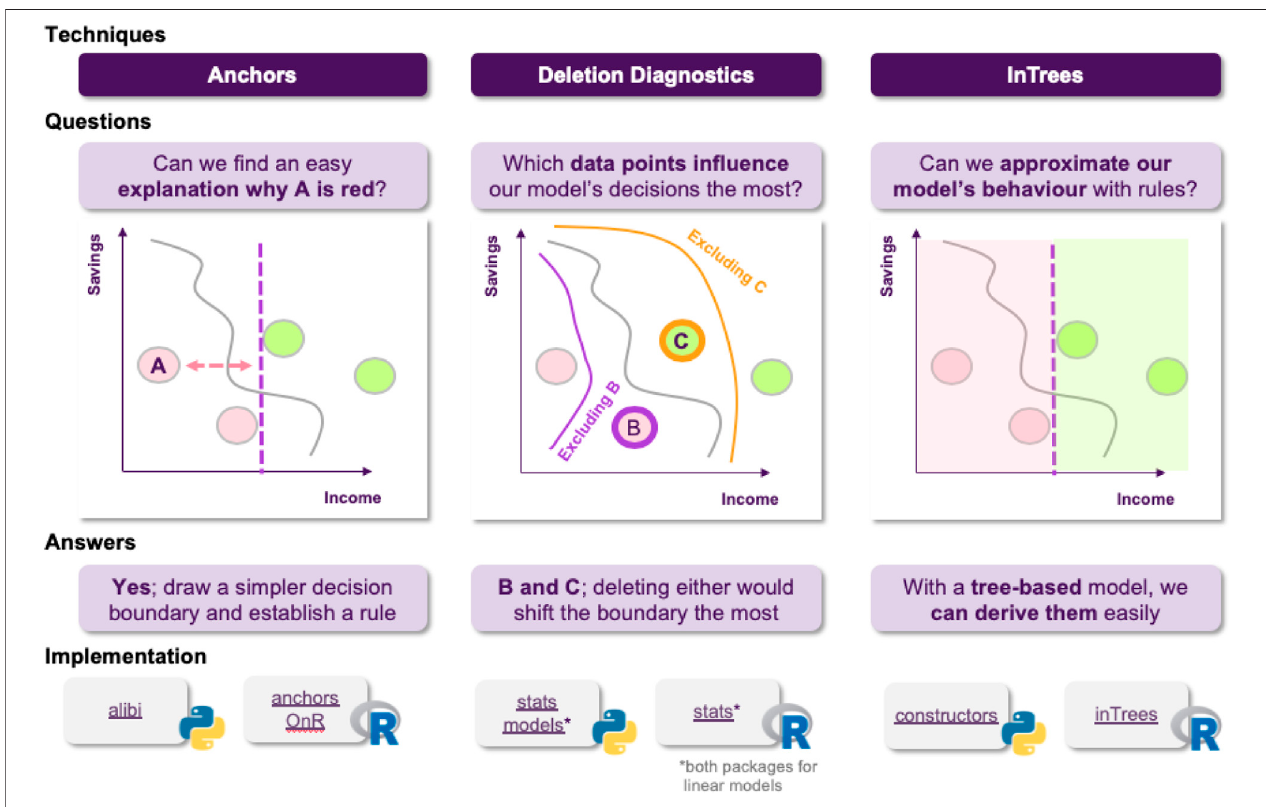
FIGURE 16 | Using anchors, deletion diagnostics and intrees, visualized in terms of instances.